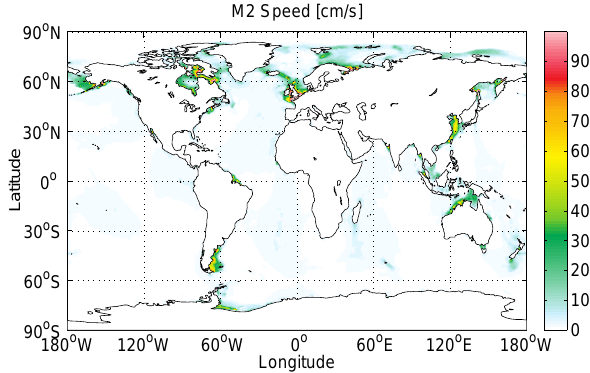
Fig. 18. M2 tidal speed map ( cms (cid:0) 1 ). High speed is mainly located Fig. 8. M2 tidal speed map (cms − 1 ). High speed is mainly located in shallow shelf regions, including some Arctic and North Atlantic in shallow shelf regions, including some Arctic and North Atlantic coastal regions. coastal regions.